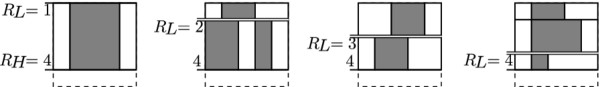
Two-dimensional intermediate tilings. Illustration of intermediate candidate tilings on a 5 × 5 grid for RH = 4.